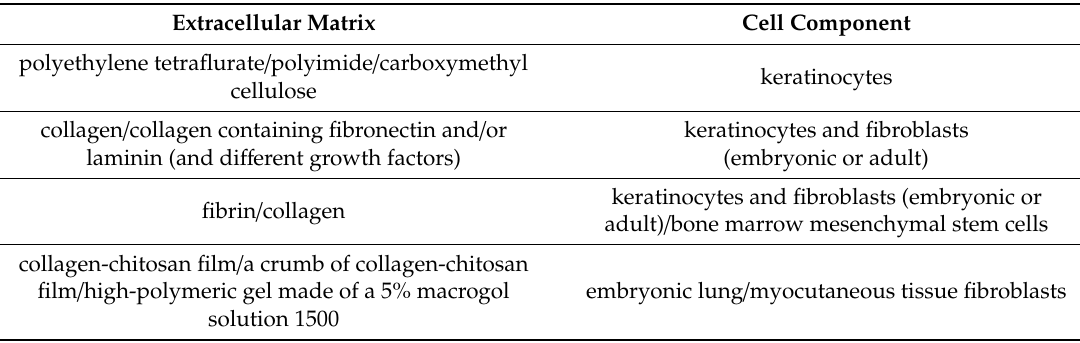
Table 1. Di ff erent types and composition of skin tissue equivalents patented in Russia in the 2000s.